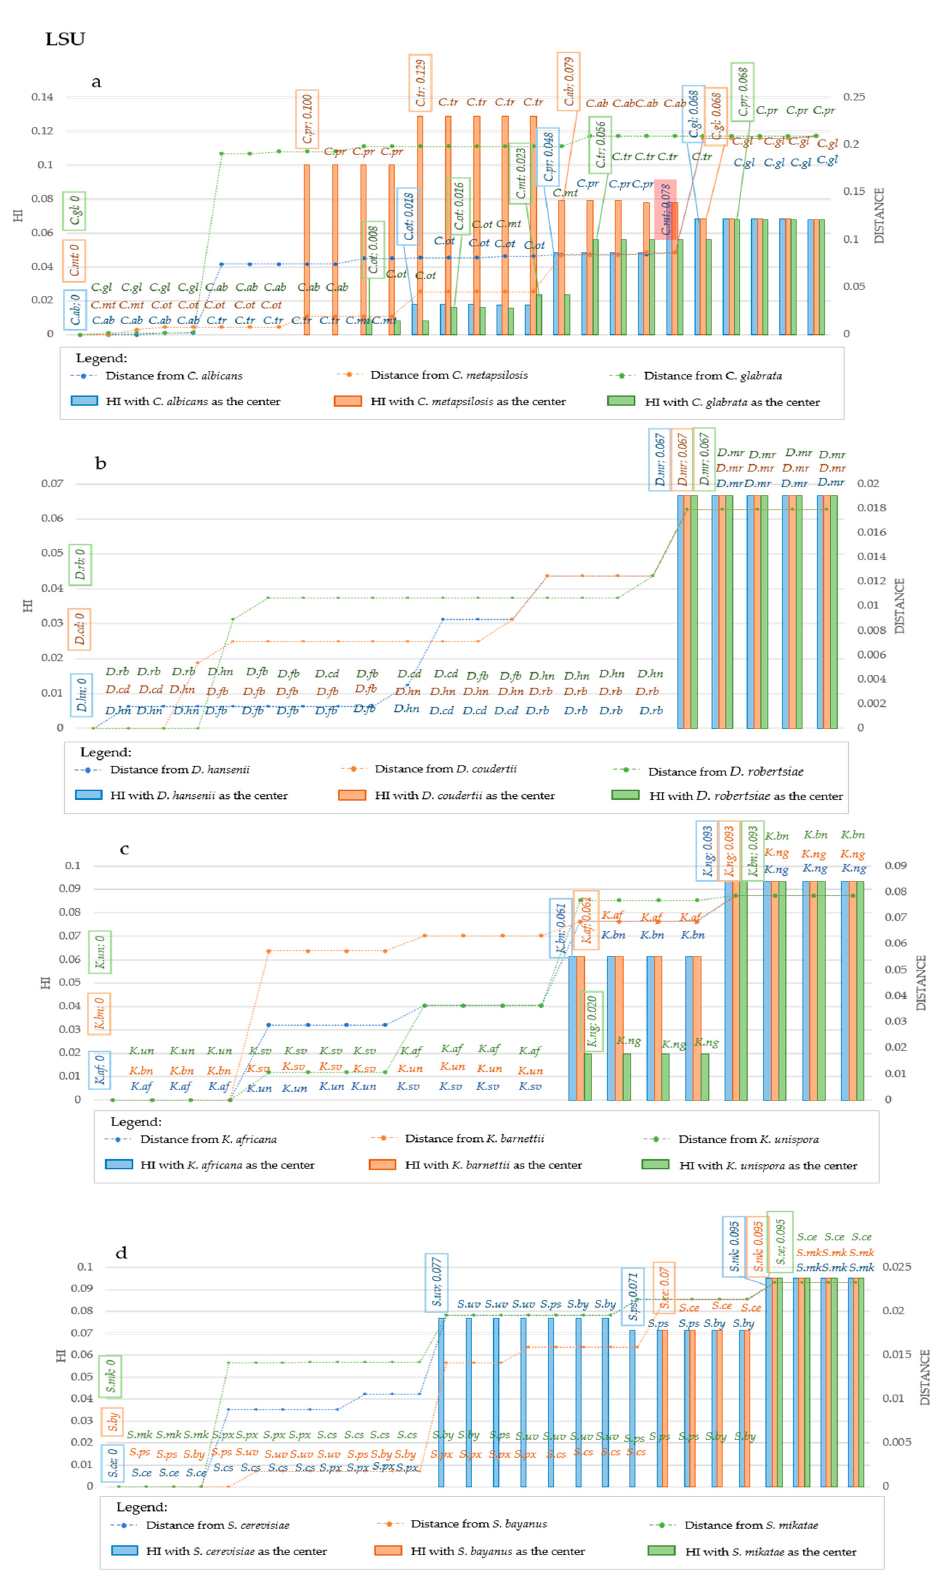
Figure 7. Homoplasy Index and Distance in LSU sequences considering different center of distribution, at strain level. The plots report the variation in Homoplasy index and distance of LSU sequences, when three different species are considered the center of the distribution. Each plot reported in the primary Y-Axis (on the left) the value of HI, while the secondary Y-Axis (on the right) reported the value of distance from the center of the distribution. In the X-Axis species are